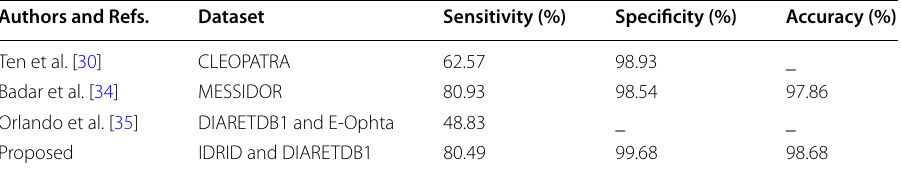
Table 2 Comparison of the results of the proposed method for retinal hemorrhage segmentation to the latest current methods in terms of accuracy, sensitivity and specificity Authors and